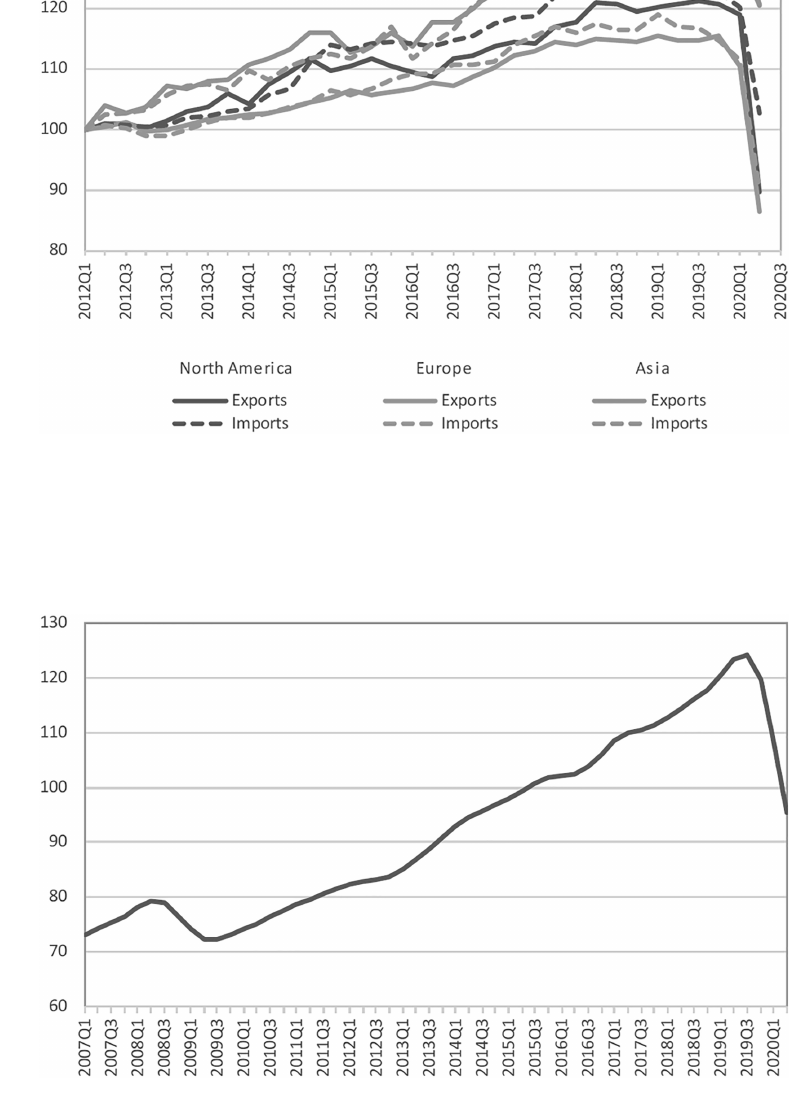
Figure A3. World services trade activity